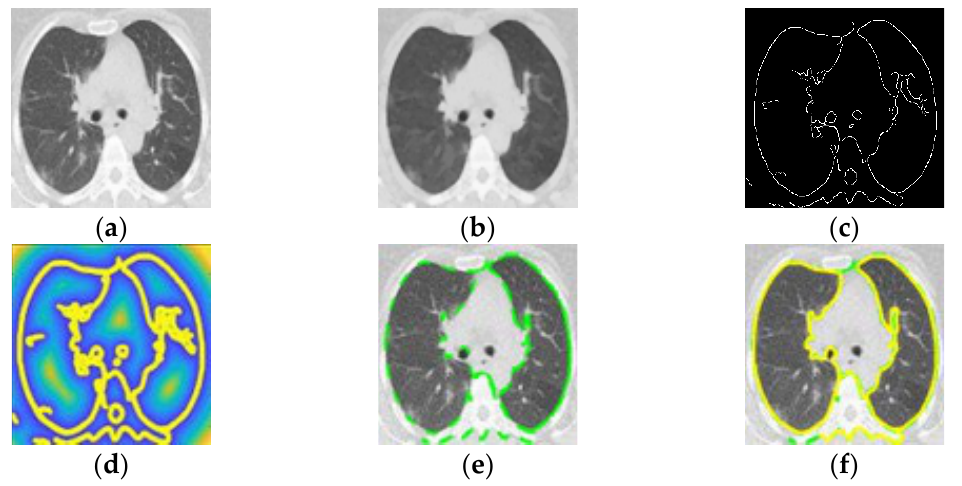
Figure 3. ( a ) Computed tomography in patient with COVID-19. ( b ) Smoothed image. ( c ) Optimized edge map B. ( d ) External energy of the VFC field superposed with isolines. ( e ) PIG initialization. ( f ) Final snake deformation.